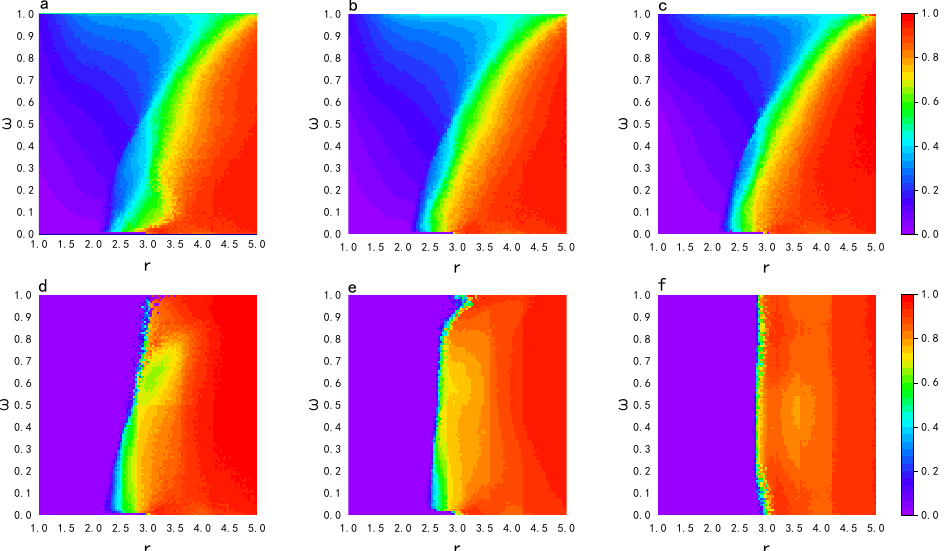
Figure 7. Relationships between population cooperation levels and the parameter ( ω , r ) for different memory stability coefficients α . ( a – f ) represent α = infinite, 5, 4, 3, 2, 1, respectively. Color coding indicates the average cooperation level ρ c , as shown on the right side of each graph.